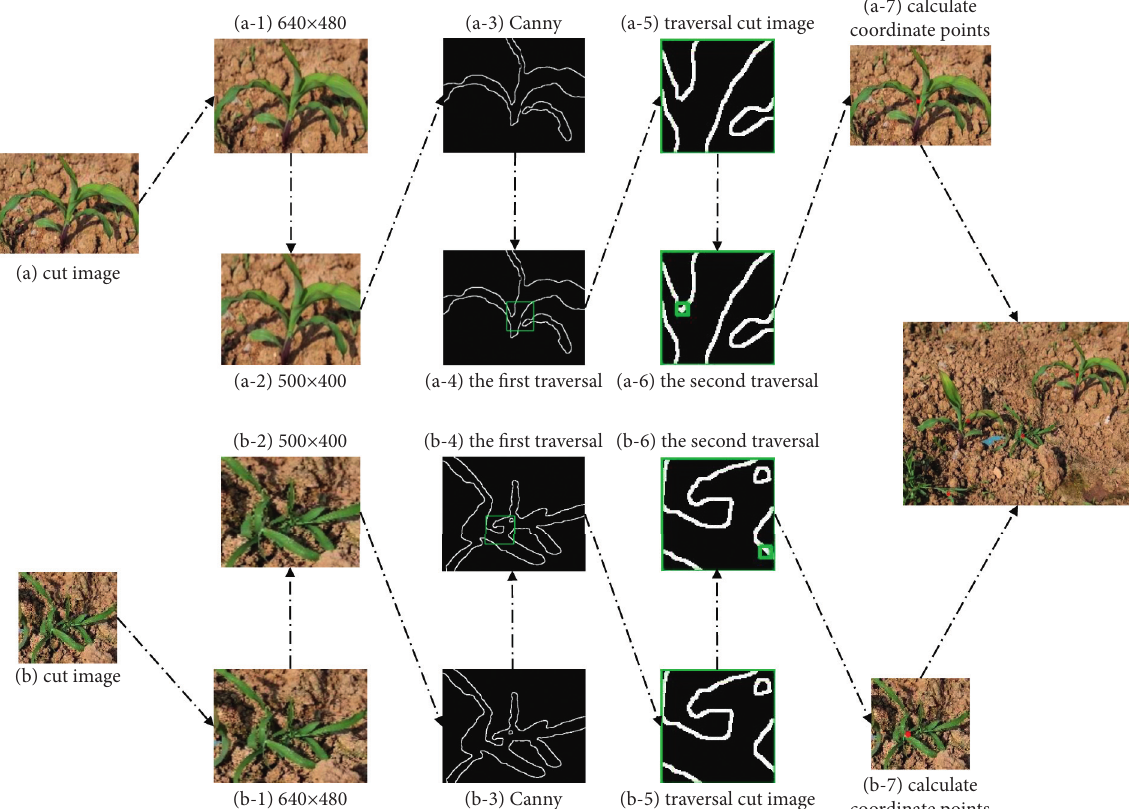
Figure 10: Schematic diagram of the quadratic traversal algorithm for selecting the target 2D coordinate points. (a) The process of selecting 2D coordinate points of corn. (b) The process of selecting 2D coordinate points of